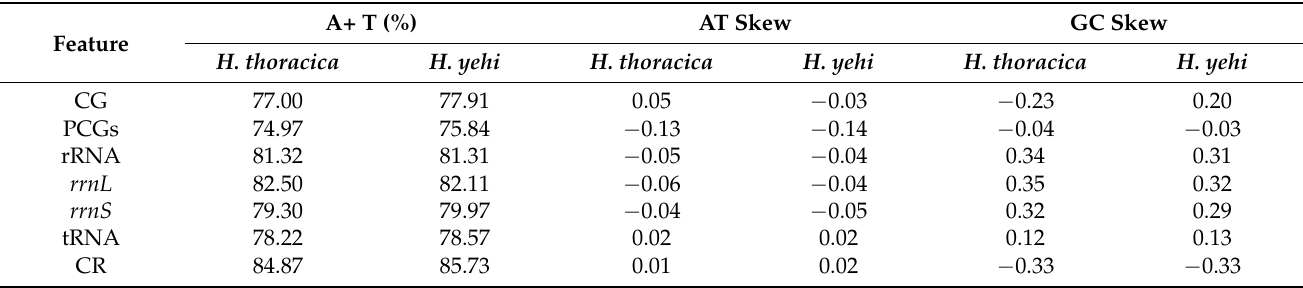
Table 2. Base composition and strand bias of these two